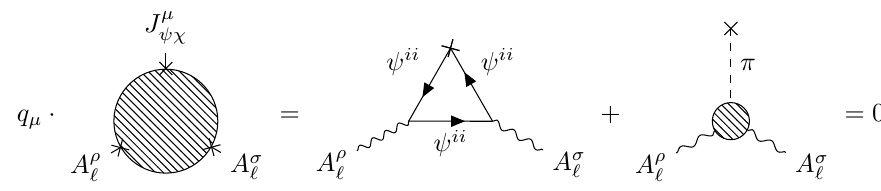
Figure 1 . In UV, the absence of the gauge anomaly in the U(1) ψχ symmetry is due to the cancellation of anomalies from the ψ and χ fermions (see (3.24)). At low energies it is secured by the cancellation between the contribution of the ψ ii loops ( i = 1 , 2 , . . . , N − 1 ) and the pion pole term. The requirement that the sum of the two cancel, is nothing but the π → A given by